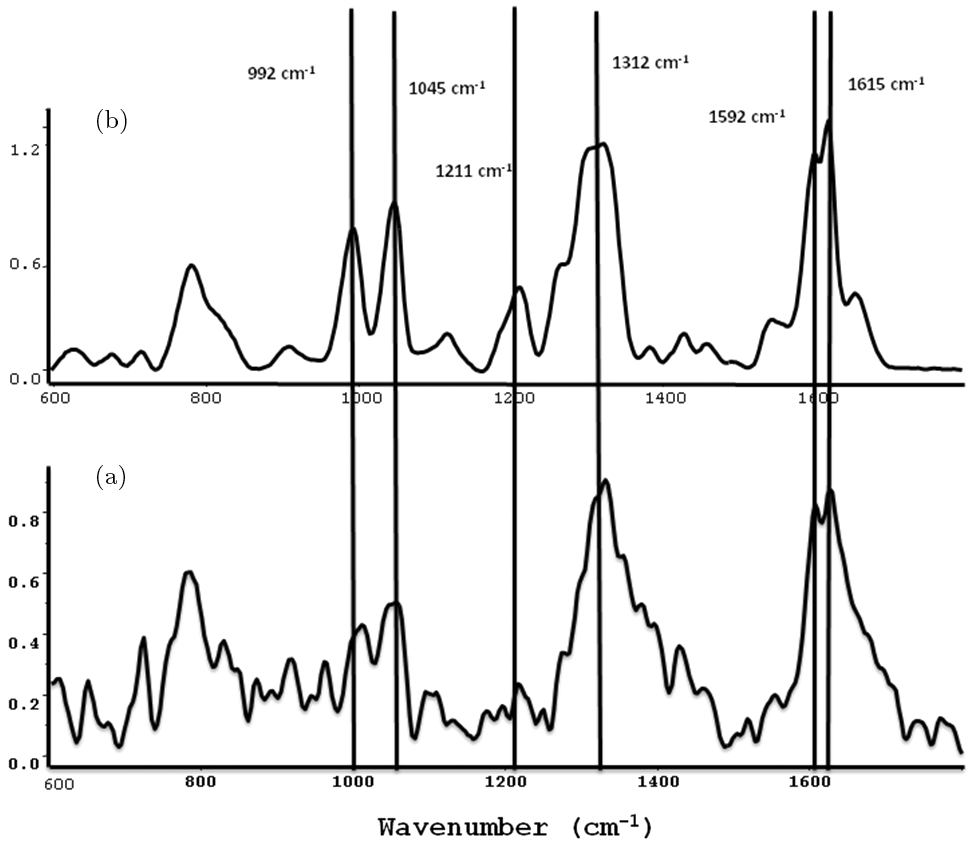
Fig. 1. Representative spectra for conventional Raman approach in drug spiked milli-q. Spectra were acquired from Imatinib spiked milli-q and representative spectra for 5 and 1 mg/mL are shown in the ¯gure, (a) Lowest concentration: 1mg/mL, (b) Highest concentration: 5